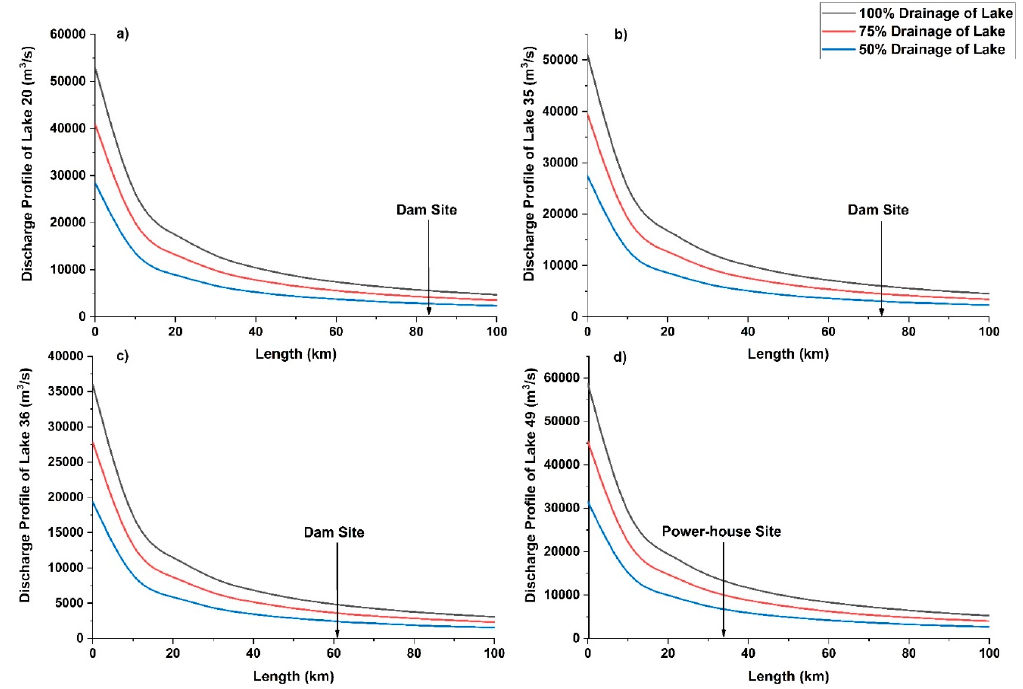
Figure 7. Discharge profiles of lake nos. 20, 35, 36, and 39 with 100%, 75%, and 50% drainage in ( a )–( d ), respectively, from the outburst site to the downstream region. Table 4. Maximum discharge and physical features of the critical lakes.